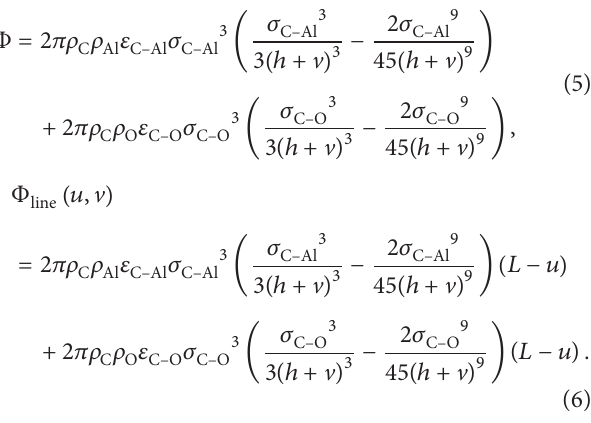
If a displacement ( 𝑢 , V ) is given, (2) and (3) are changed